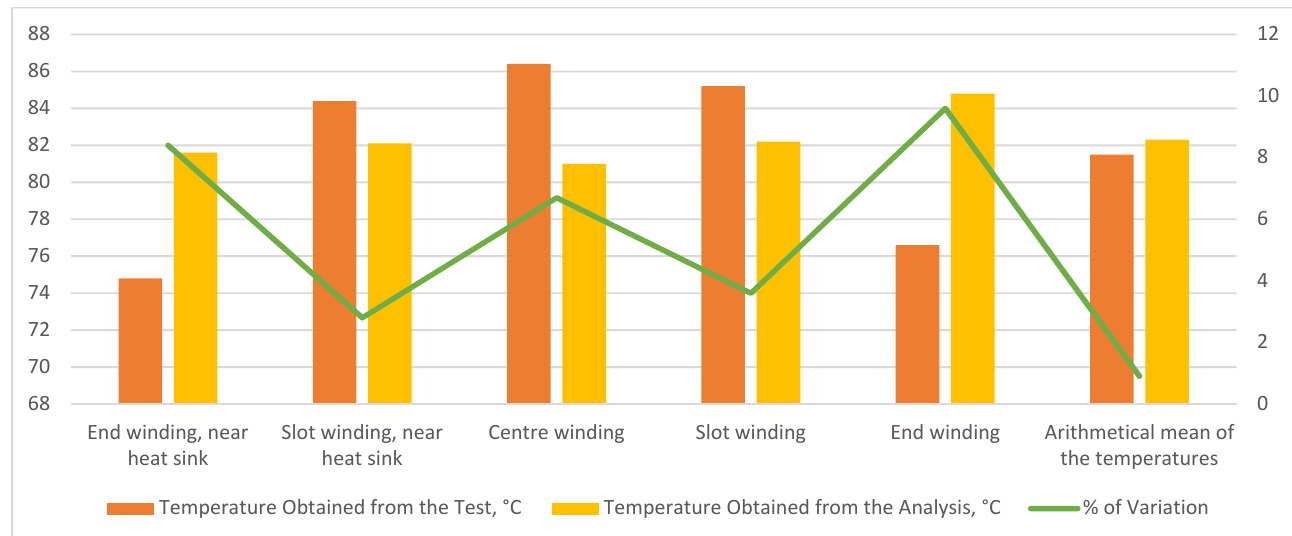
Figure 6. Results of increase in stator winding temperature [27].